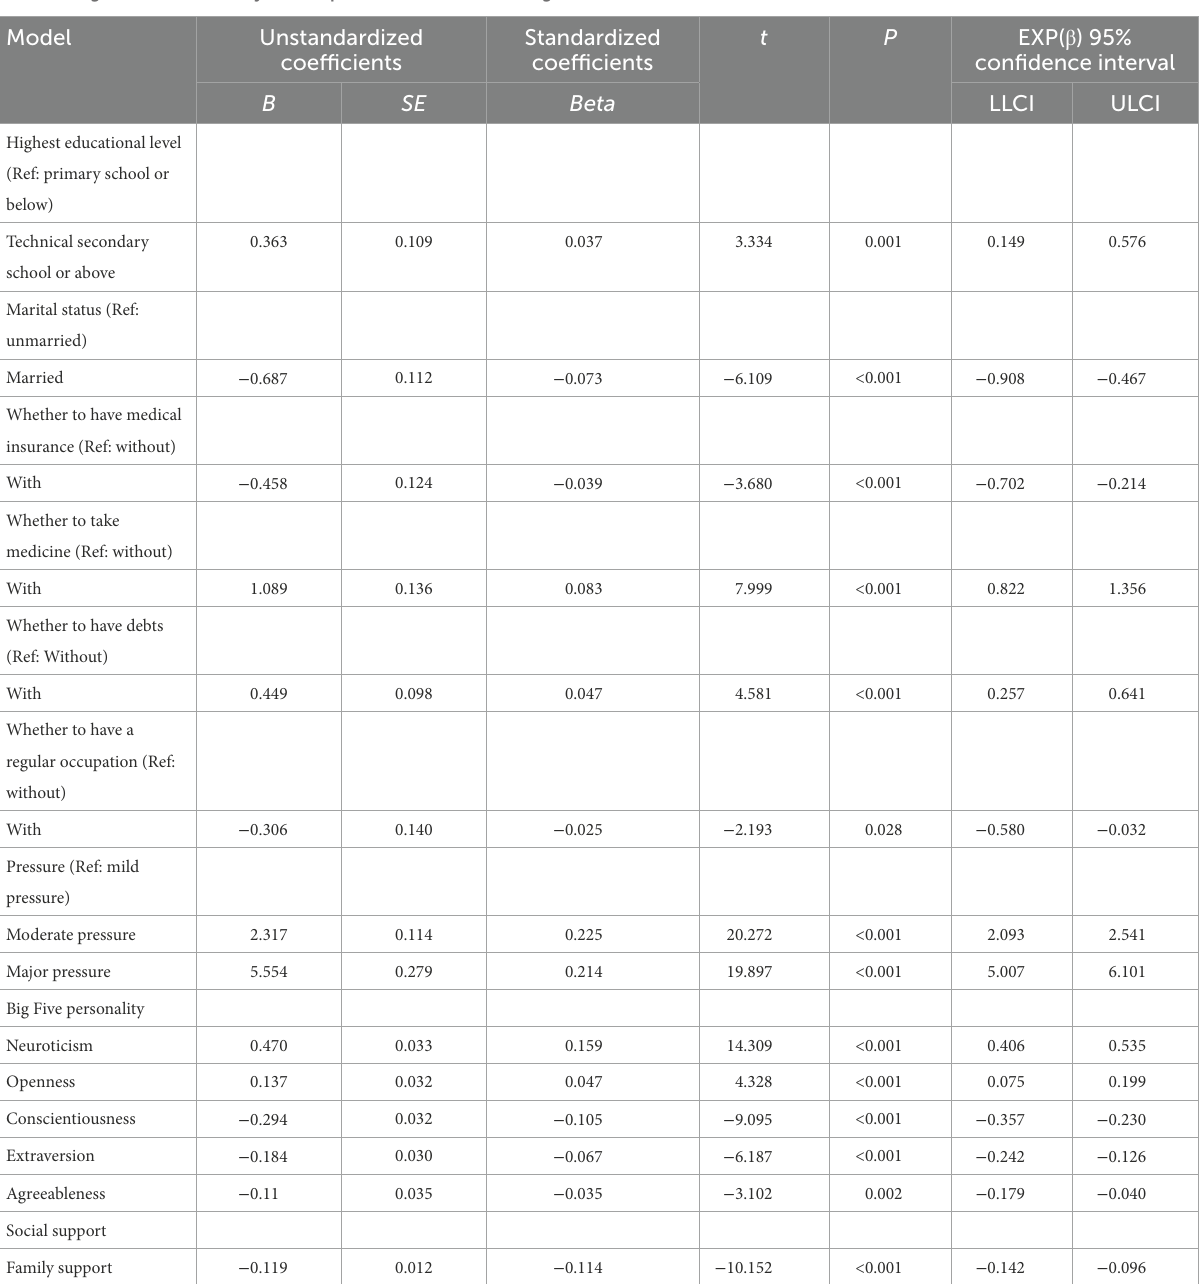
TABLE 6 Regression model analysis of depression in the media use